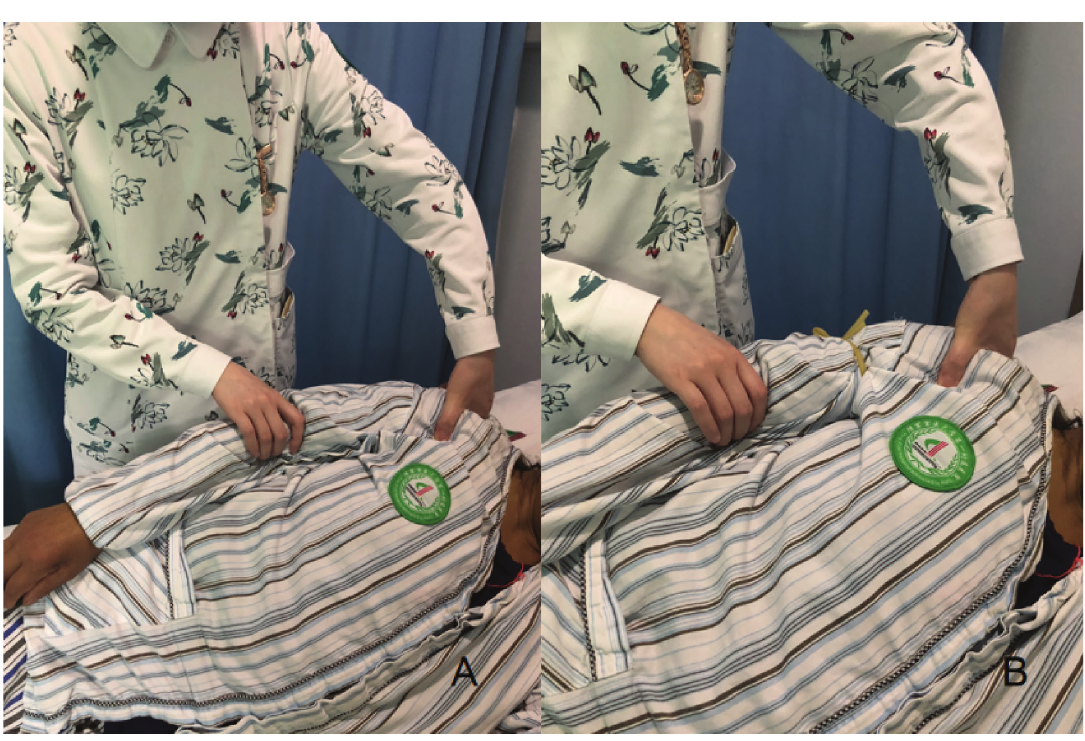
Figure 2. X-ray and CT scan results of the broken catheter inside the body by (A) chest positive tablets; (B) chest lateral tablets; and (C) enhanced CT, showing that the catheter was stranded in the left and right pulmonary artery trunk and branches; the ruptured catheter is indicated by an arrow.